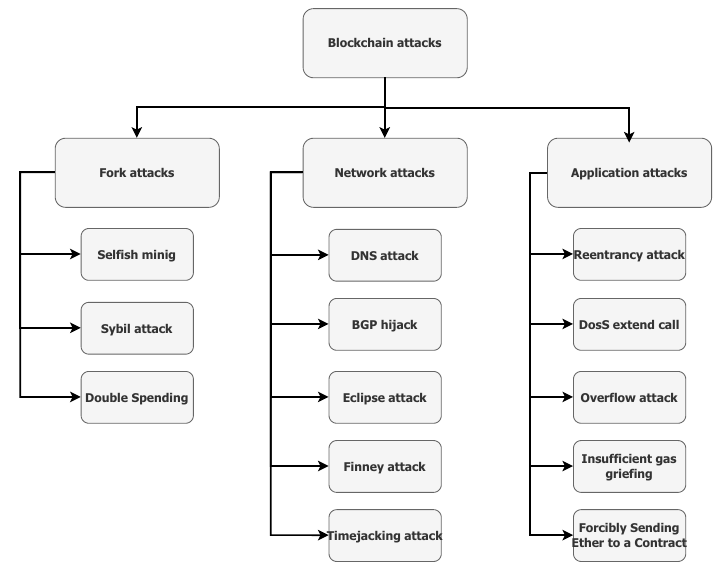
Figure 2. Taxonomy of blockchain